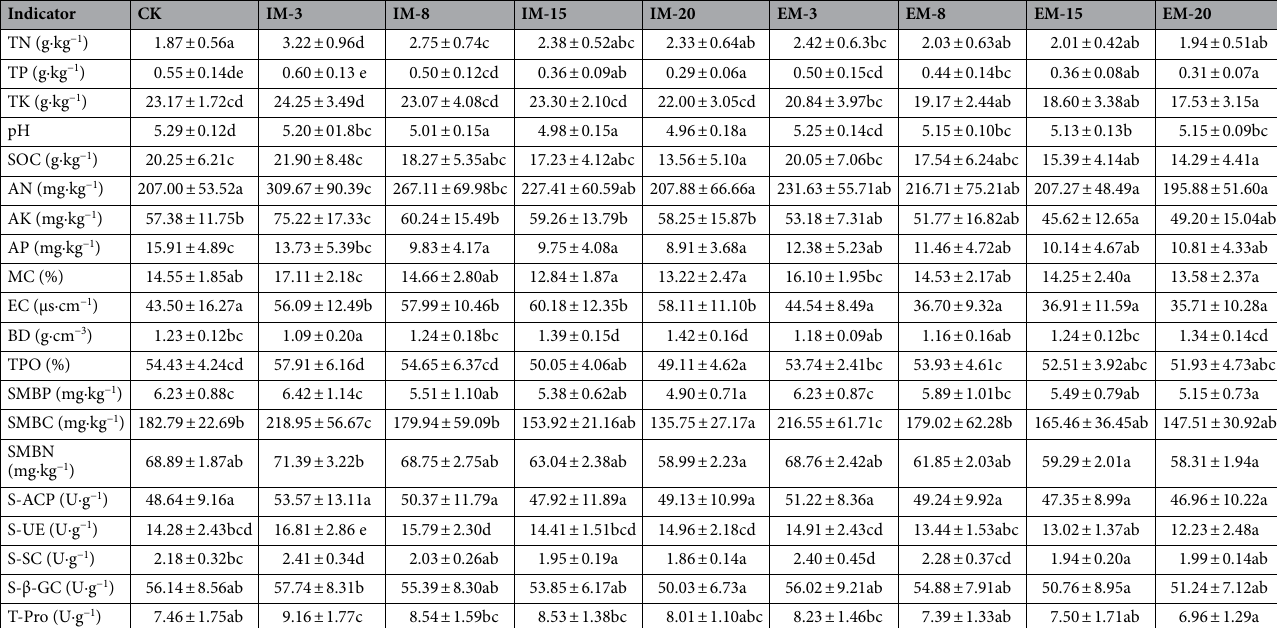
Table 1. Statistics of soil chemical, physical, and biological indicators in C. dabieshanensis forests under different management intensities and durations. There are significant differences in the one-way ANOVA of various compound patterns with different letters (LSD, p < 0.05).